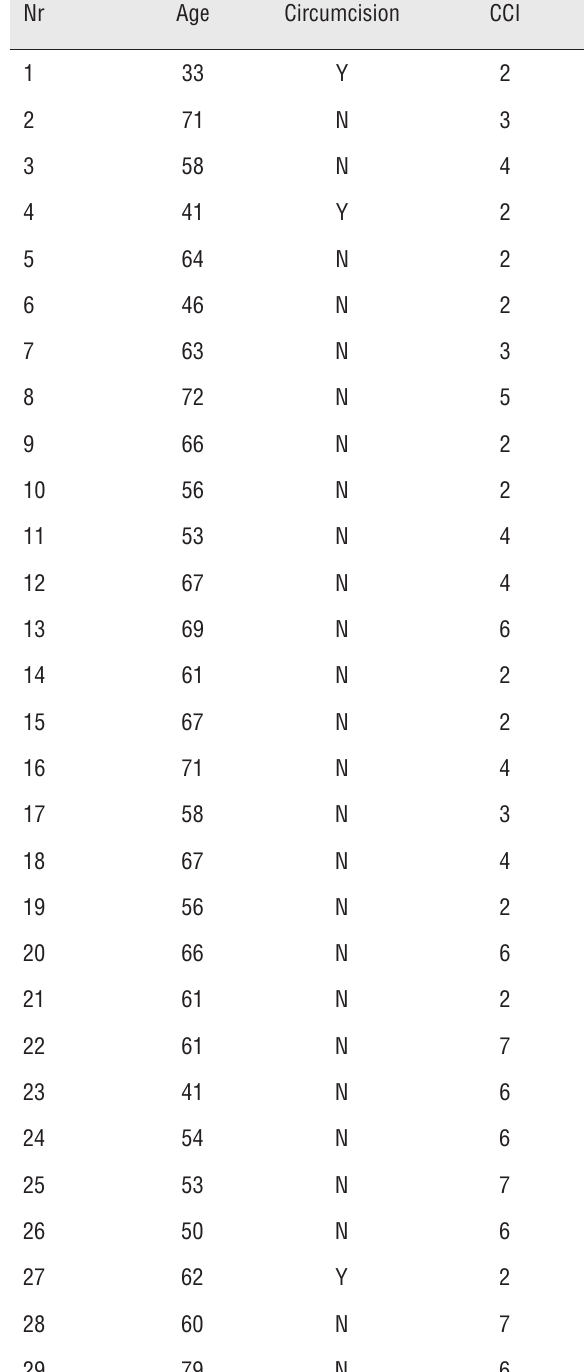
Table 1 - Demographic and clinical characteristics of the study cohort. Nr - patient number, age in years at cancer diagnosis, CCI - Charlson Comorbidity Index, Y/N - circumcision in the past before cancer diagnosis